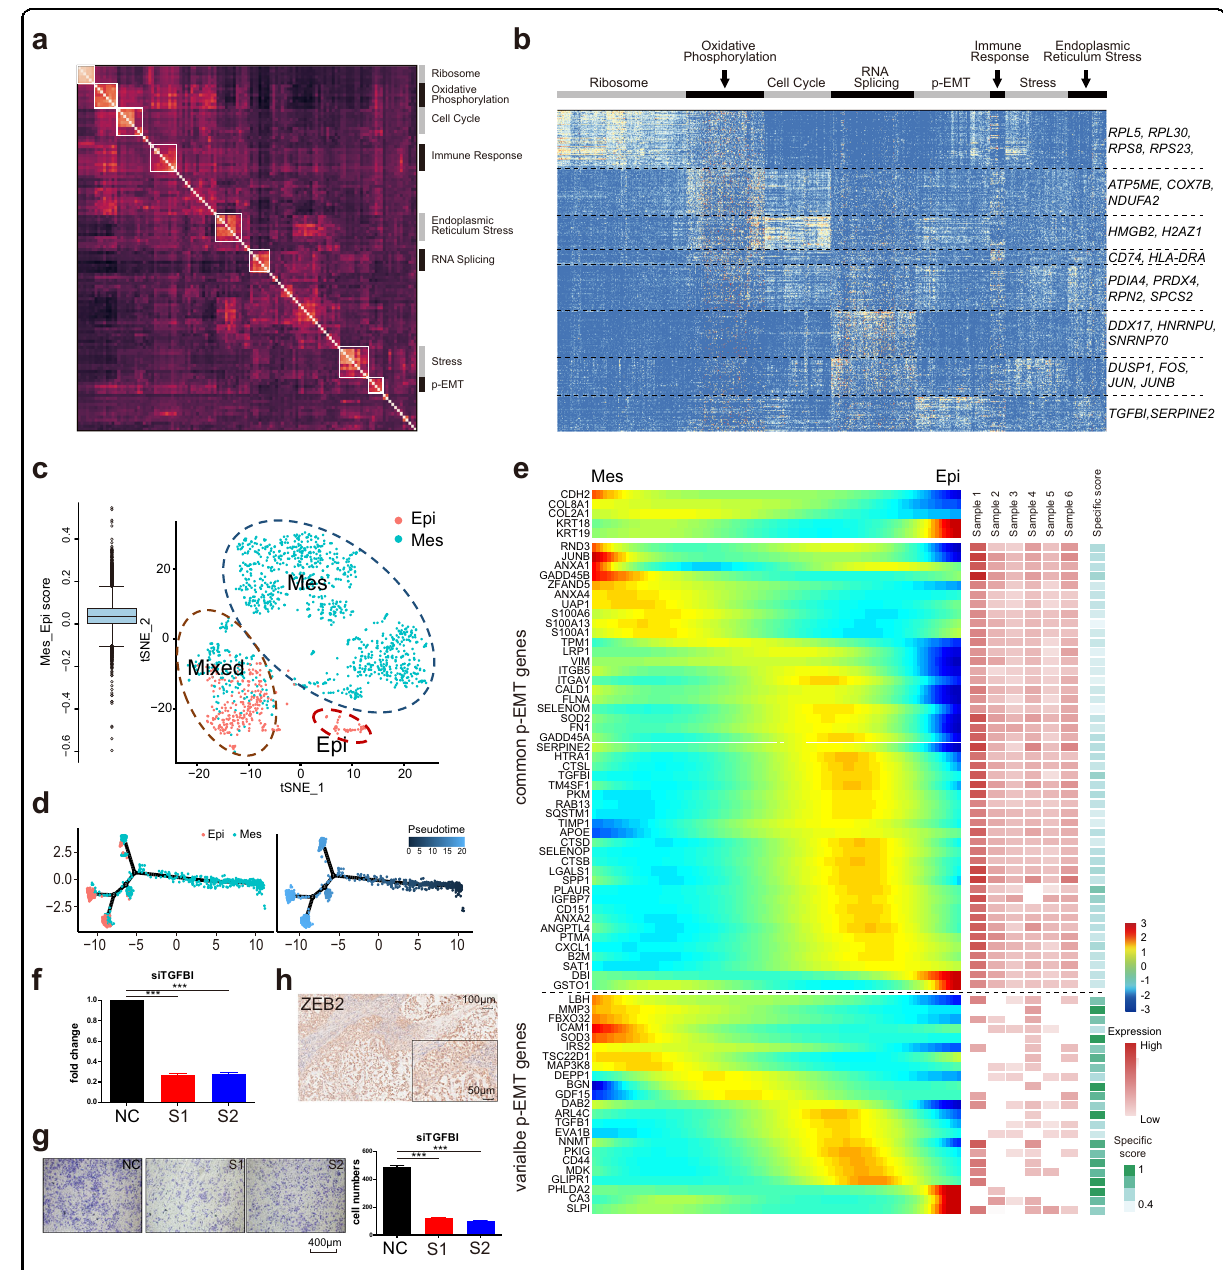
Fig. 4 Unbiased clustering reveals a common program of p-EMT in SBC. a Heatmap depicted pairwise correlations of 120 intratumoral programs derived from six patients. Eight meta-signatures re fl ected intratumoral programs. b Heatmap showed differentially expressed genes (rows) identi fi ed by non-negative matrix factorization (NNMF) clustered by their expression across single cells (columns) from a representative tumor (Patient 1). The gene clusters reveal intratumoral programs that are differentially expressed in Patient 1. The corresponding gene signatures were numbered, and selected genes were indicated (right). c The 1,374 cells identi fi ed as the Mes-type or the Epi-type were clustered and visualized. d Single-cell trajectories and the variations of gene pseudotime were visualized. e Heatmap showed NNMF gene scores aggregated by samples common (top rows) and tumor-speci fi c (bottom rows) genes within the p-EMT program. f , g Knockdown of TGFBI by siRNA attenuated the invasiveness of UM- chor1. The results of quanti fi cation were shown on the right side. S1, S2: two different siRNA. NC: normal control. Scale bar, 400 μ m, *** P -value ≤ 0.001. h IHC demonstrated that the expression of ZEB2 was involved in the p-EMT program of